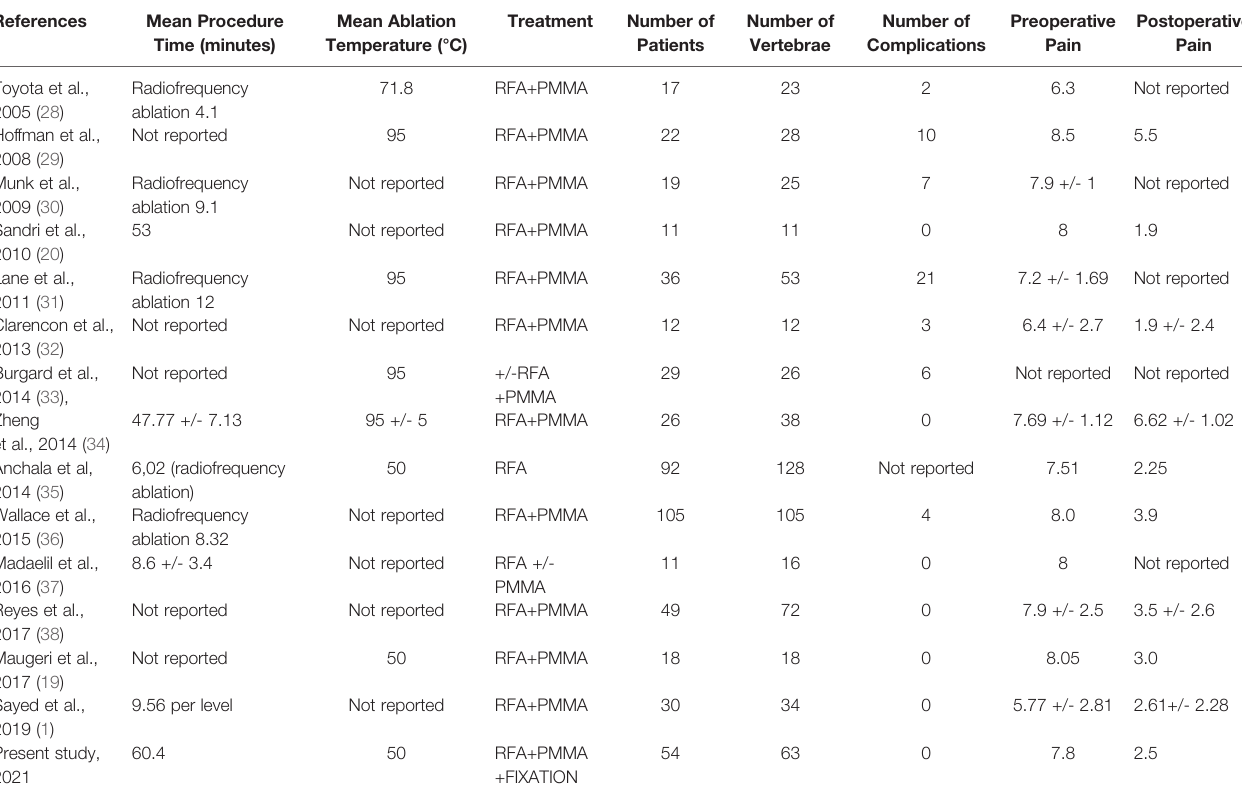
TABLE 2 | Literature review of the largest reported clinical series of patients treated by RFA and PMMA vertebral